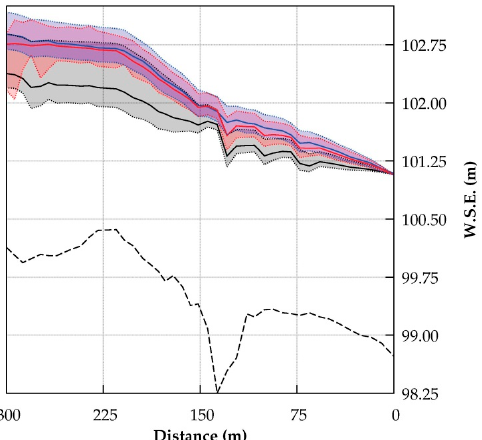
Figure 3. Sensitivity analysis—Longitudinal profile plot of C.2 at high flow conditions ( 𝐻𝑄 1 ) including bed elevations (dashed black line) and modelled water surface elevations (W.S.E.) (results of 1D simulations = blue solid line, 2D simulations = red solid line and 3D simulations = black solid line) with a bandwidth considering +/ − 20% of roughness changes (dotted lines with corresponding colors).